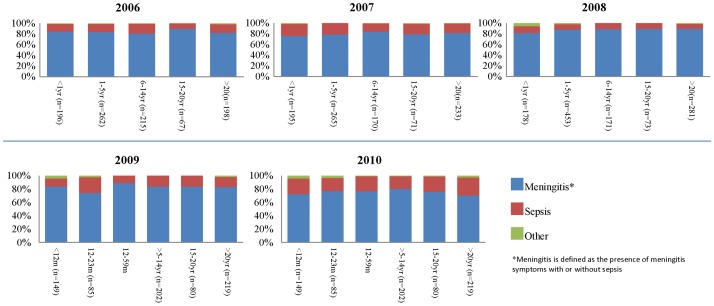
Meningococal disease presentation in Latin America and the Caribbean, 2006–2010.*Meningitis is defined as the presence of meningitis symptoms with or without sepsis.